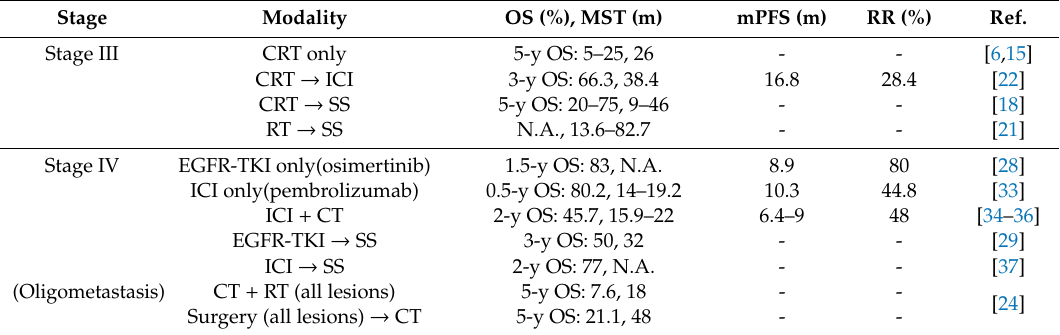
Table 1. Selected studies on salvage surgery and first-line therapy for stage III / IV